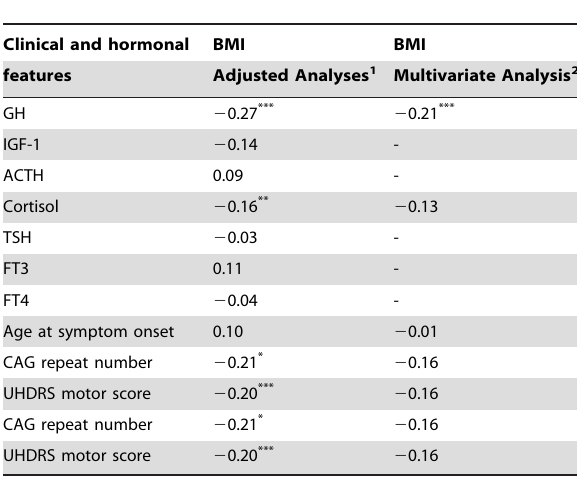
Table 4. Relationship between body mass index and clinical and hormonal